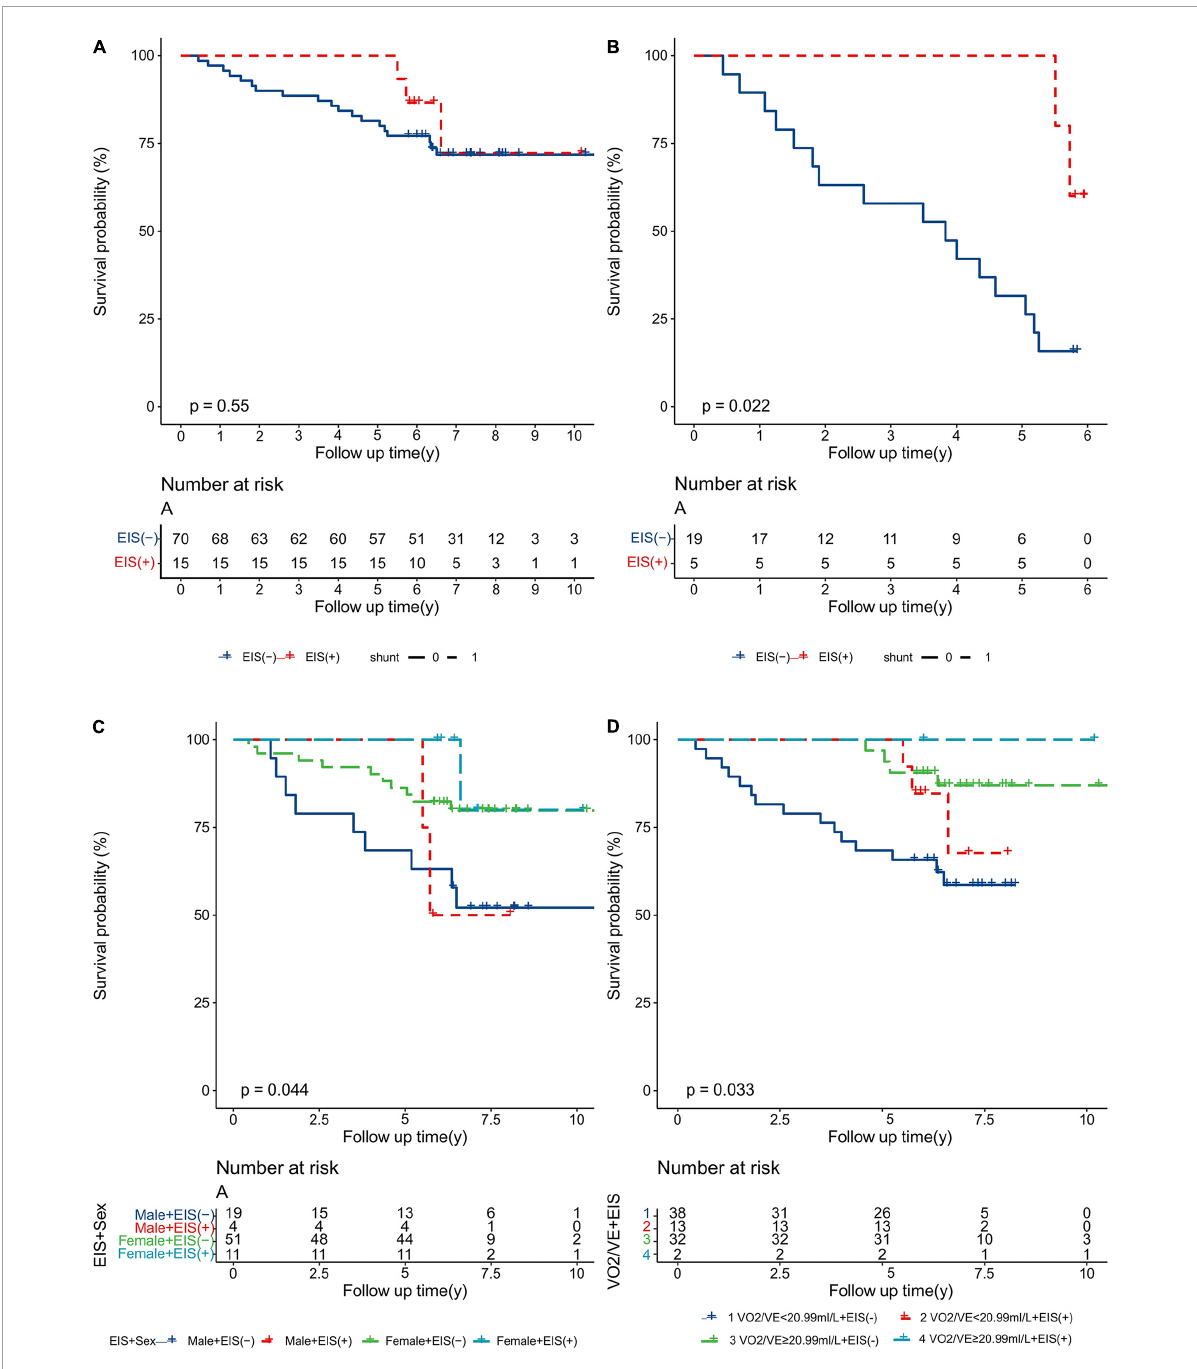
FIGURE6 Kaplan–Meier analysis for all-cause mortality in IPAH patients, separated by (A) 10-year survival; (B) 6-year survival; (C) sex and EIS; and (D) VO 2 /VE and EIS. EIS, exercise-induced right-to-left shunt; VE, minute ventilation; VO 2 , oxygen uptake; IPAH, idiopathic pulmonary arterial